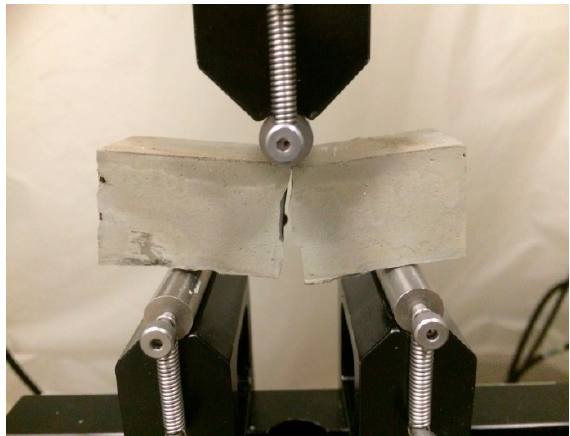
Figure 7. The propagation of the crack during the three-point bending test.